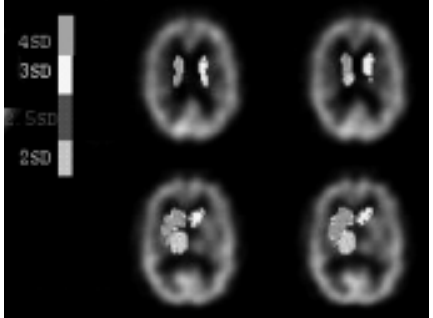
Fig. 2. Quantified ECD SPECT eight months after stroke disclosing hypoperfusions in the thalamus, both caudate nuclei and the left lentiform